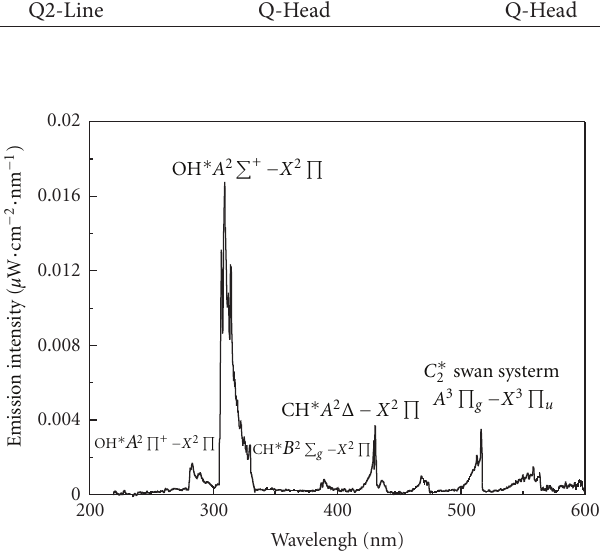
F 3: Typical spectrum of CH